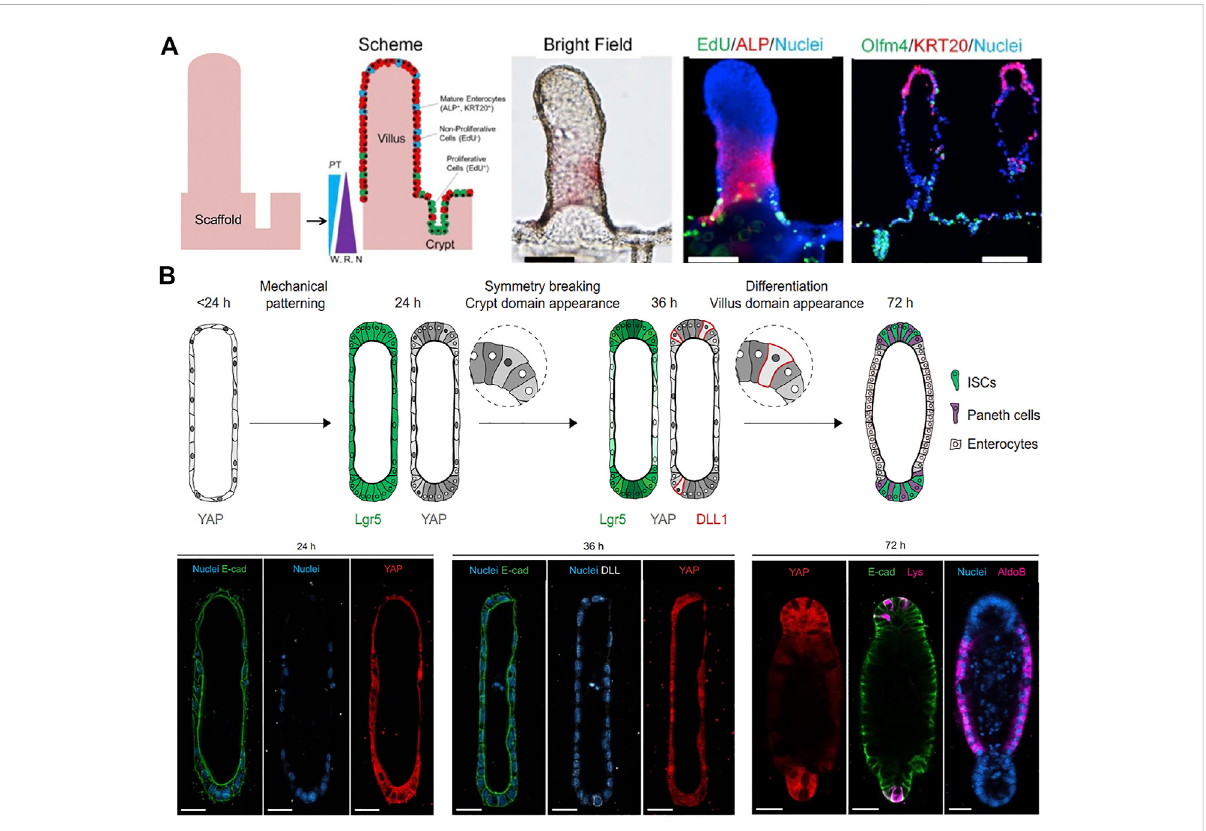
FIGURE 3 Geometry-guidedmorphogenesisofintestinalorganoids. (A) Invitro crypt-villusstructureformationandtissuepolarizationbyculturinghuman intestinalcellsonamicropatternedcollagenscaffoldunderthegradientofgrowthfactors(W:Wnt-3A;R:R-spondin3;N:noggin).Adaptedfromref. (Wang et al., 2017). (B) Schematic illustration of the proposed mechanism of the initial geometry-driven epithelial organoid patterning. Immuno fl uorescence images showing the distribution of YAP cells, Notch ligand DLL + cells, enterocytes (aldoB), and Paneth cells (Lys) in the organoids at 24, 36, and 72 h of ISC seeding. Adapted from ref. (Gjorevski et al., 2022). Scale bars, (A) 100 μ m and (B) 25 μ